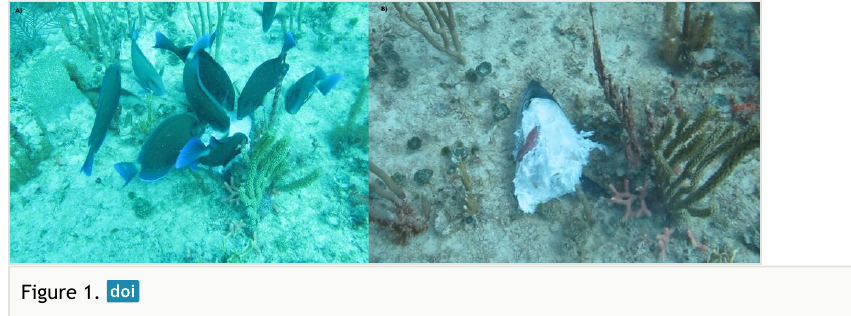
Two frames of the video showing surgeonfish tearing apart a tuna head (A). The fish head showing evidence of the surgeonfish bites (B).